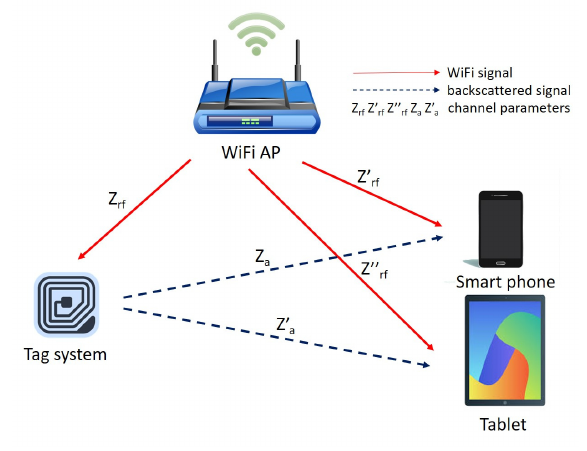
Figure 1. System